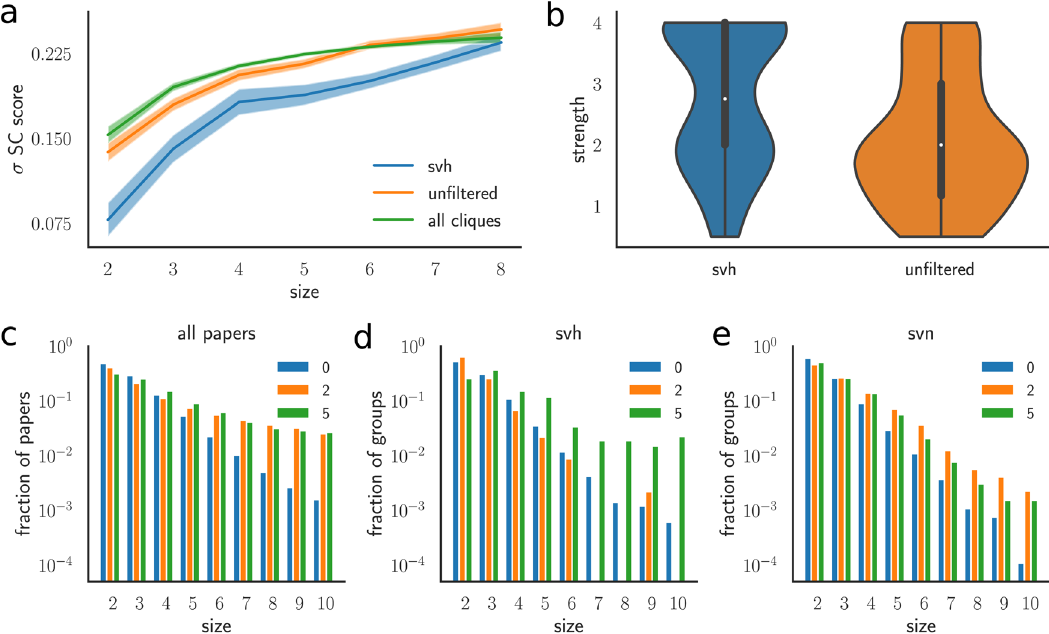
Fig. 3 Filtering real-world hypergraphs. a Average standard deviation of the Segal – Cover score as a function of a group size of justices of the US Supreme Court for the hyperlinks detected in the Statistically Validated Hypergraph (blue line), for the hyperlinks of the un fi ltered hypergraph (orange line), and all possible groups formed by justices that were jointly acting at the Supreme Court during the same time period (green line). Lines represent mean values and shaded areas represent the standard error of the mean. b Violin plots of the average strength (as reported in the survey diaries) of (i) the hyperlinks statistically validated by the SVH (blue box) and (ii) the hyperlinks of the un fi ltered hypergraph (orange box). c Fractions of papers written by groups of authors of different sizes for General Physics (blue bars), Nuclear Physics (orange bars), and Physics of Gases and Plasma PACS categories. d , e Fractions of overexpressed groups of authors as a function of size n in the overexpressed hyperlinks validated by SVH ( d ) and of groups of authors that are cliques of size n in the SVN ( e ) for 0-General Physics (blue bars), 2-Nuclear Physics (orange bars), and 5-Physics of Gases and Plasma (green bars) PACS